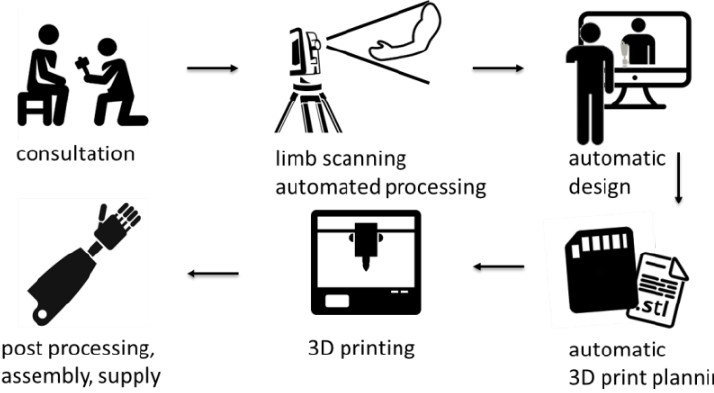
Figure 3. Workflow of the AutoMedPrint system.